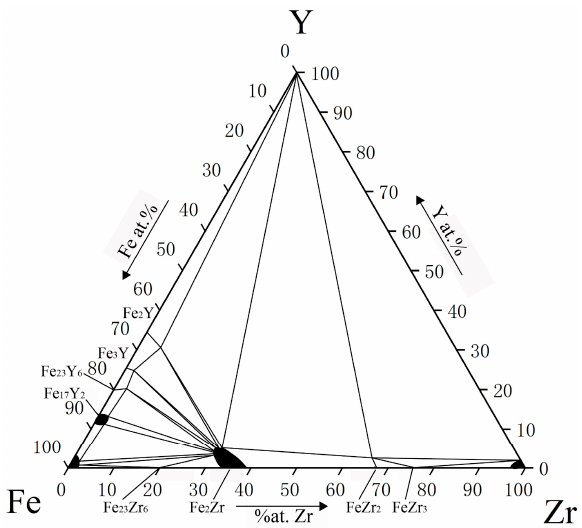
Figure 4. The 1070K isothermal section of the Fe-Zr-Y ternary system [39].